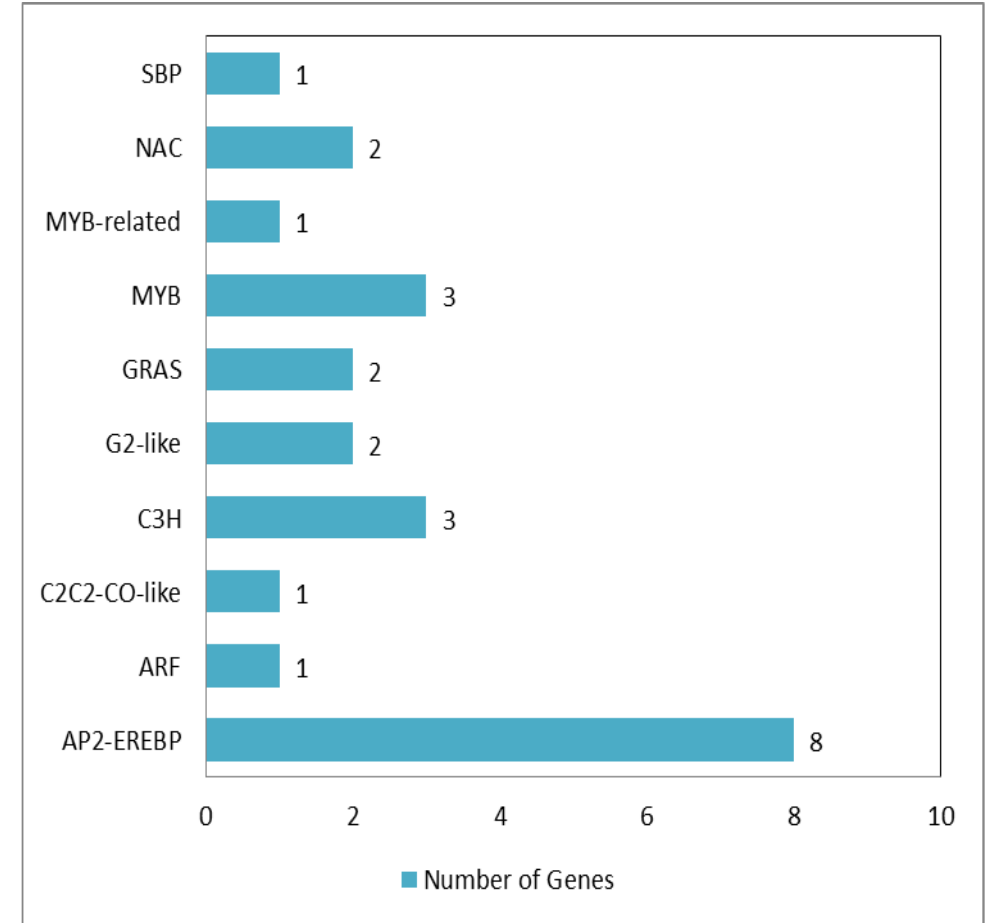
Figure 4. Abundance of transcription factors in transcription factor families in highly toxic B (TB 10 mM)-treated shoots of the T. dicoccum (Td) genotype, PI94655 compared to control (3.1 µM B) treatment.